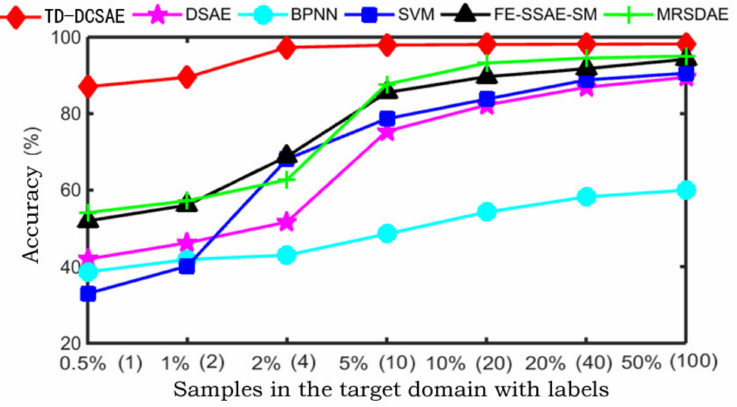
Figure 11. The accuracy of different methods under a different number of labeled samples in the target